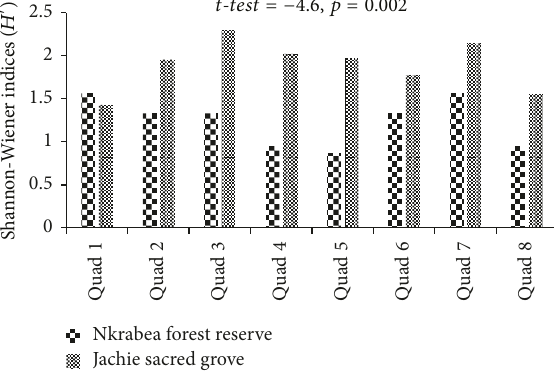
Figure 6: Variations in tree richness in Nkrabea forest reserve and Jackie sacred